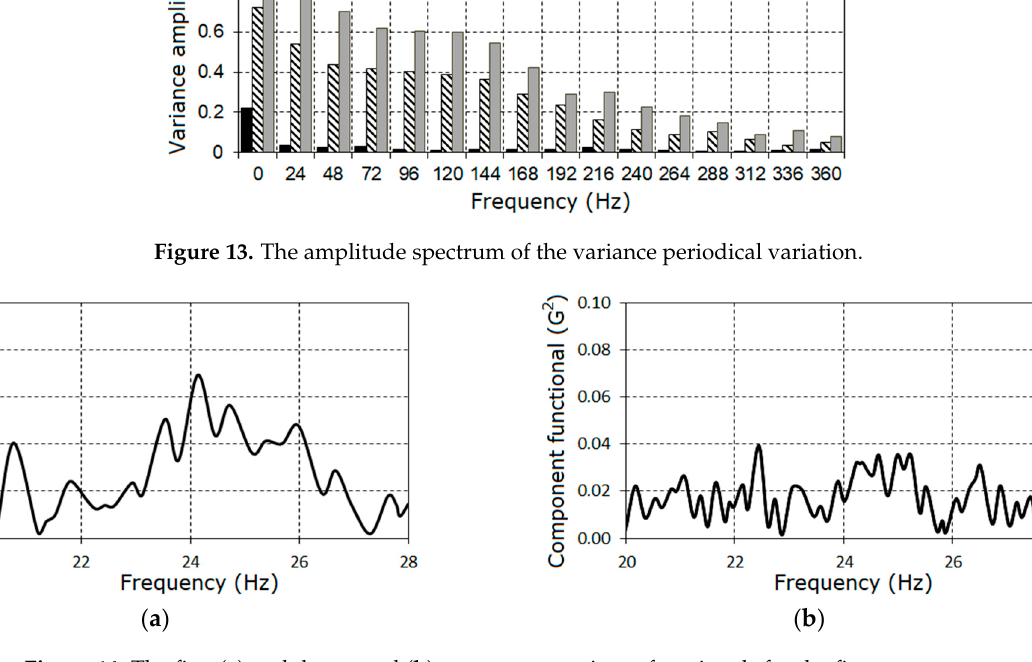
Table 2. Amplitudes of the variances time